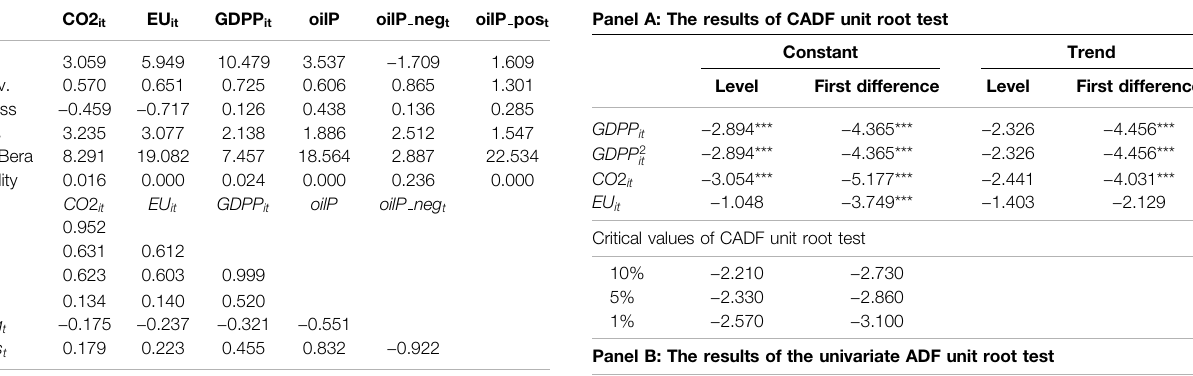
TABLE 1 | Descriptive